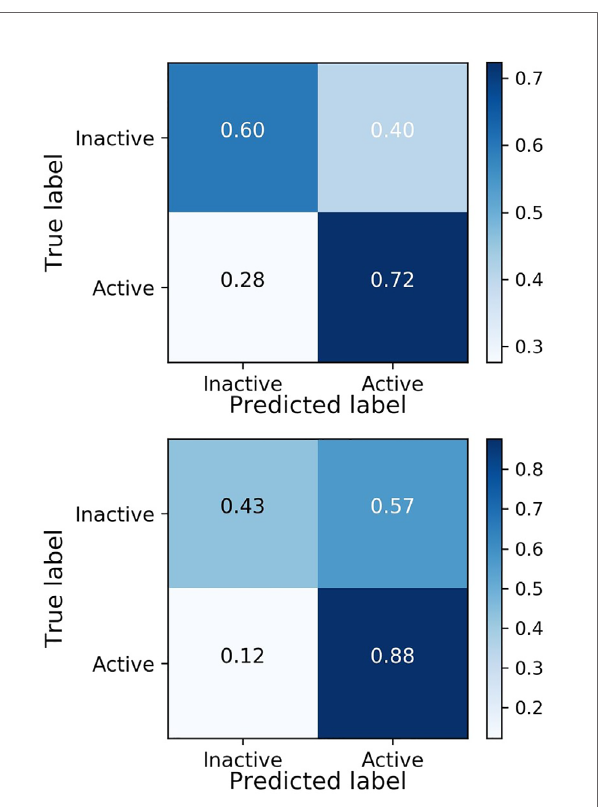
FIGURE 4 | Confusion matrices of validation dataset (A) and test dataset (B)